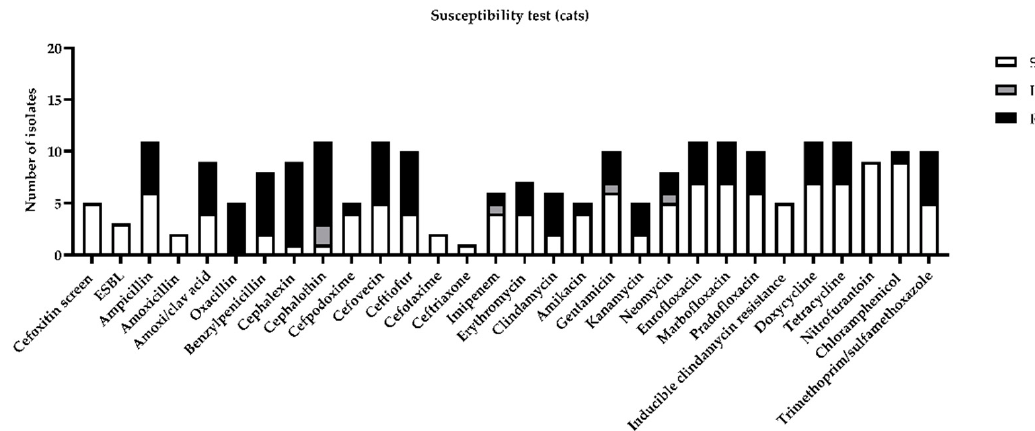
Figure 3. Figure represents sensitivity (S), intermediate (I), or resistance (R) to different antimicrobial drugs tested in susceptibility test, according to minimal inhibitory concentration (MIC) values considered by CLSI guidelines [11].